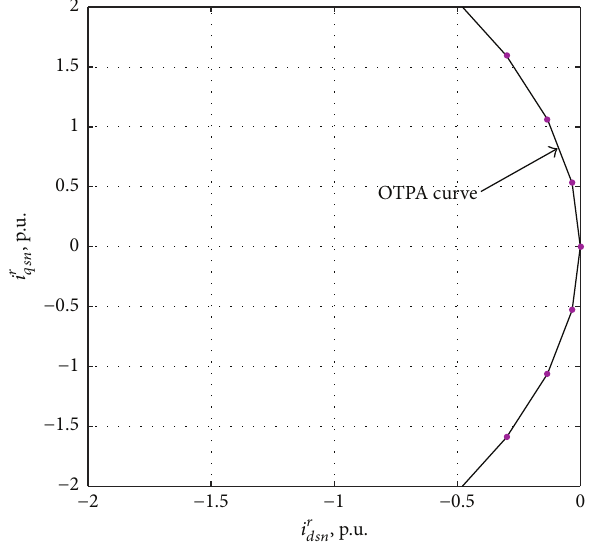
Figure 3: OTPA locus in 𝑖 𝑟 𝑑𝑠 and 𝑖 𝑟 𝑞𝑠 frame.